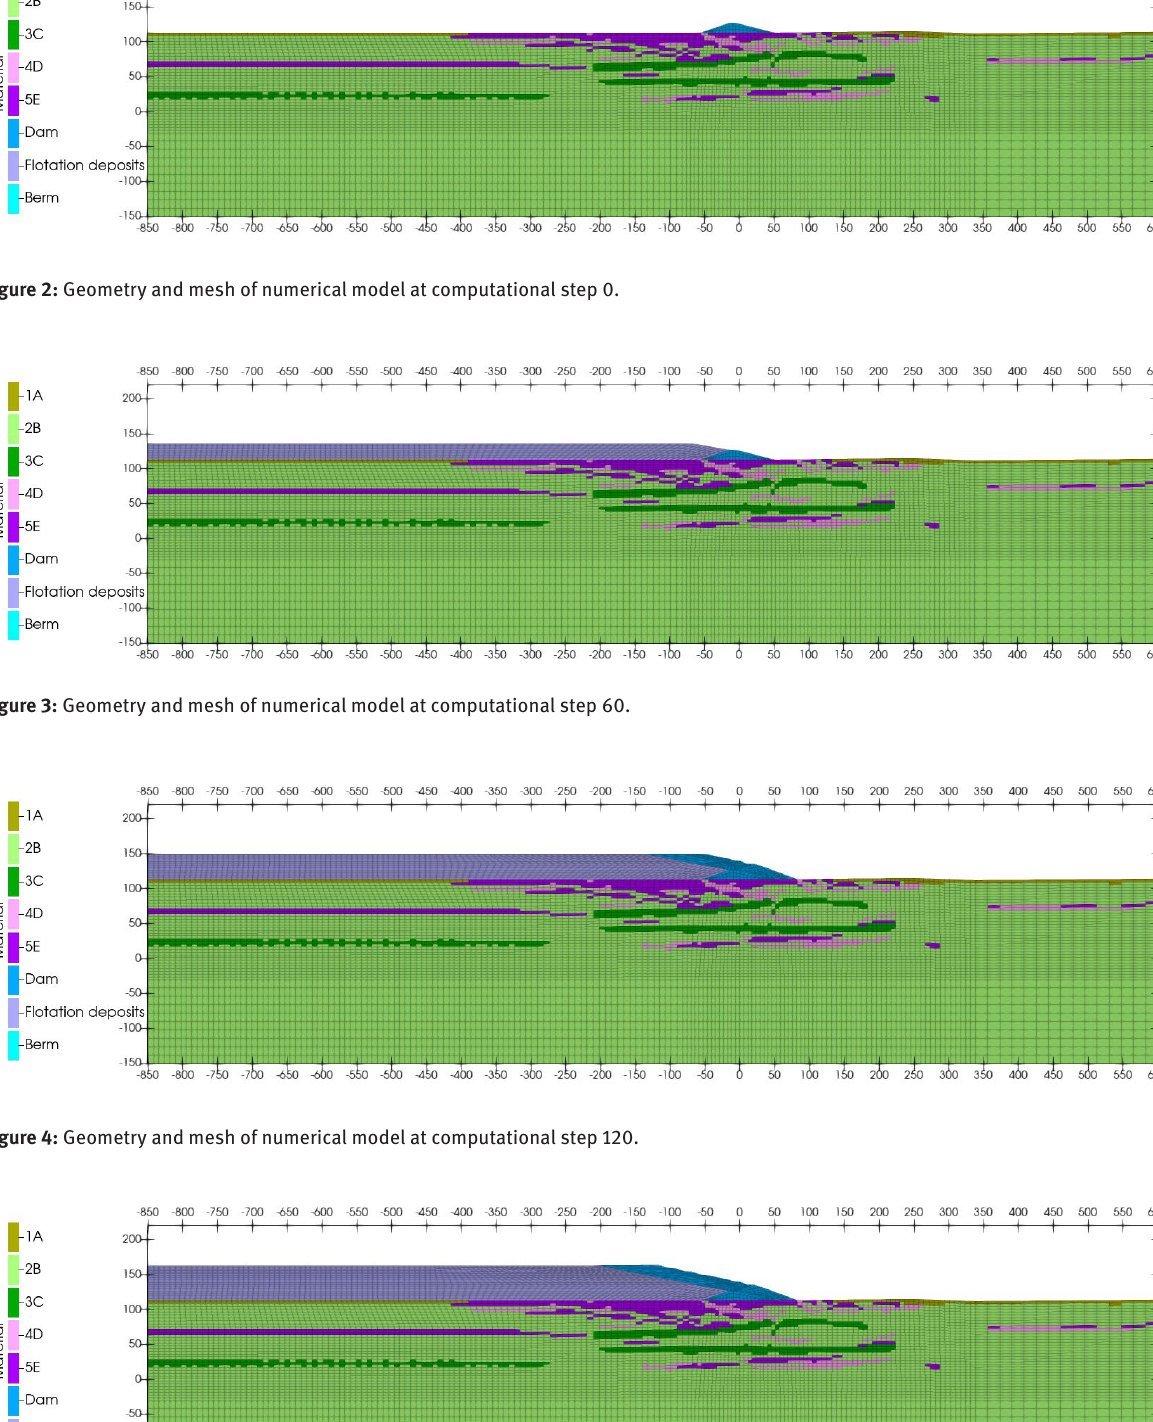
Figure 5: Geometry and mesh of numerical model at computational step 160.